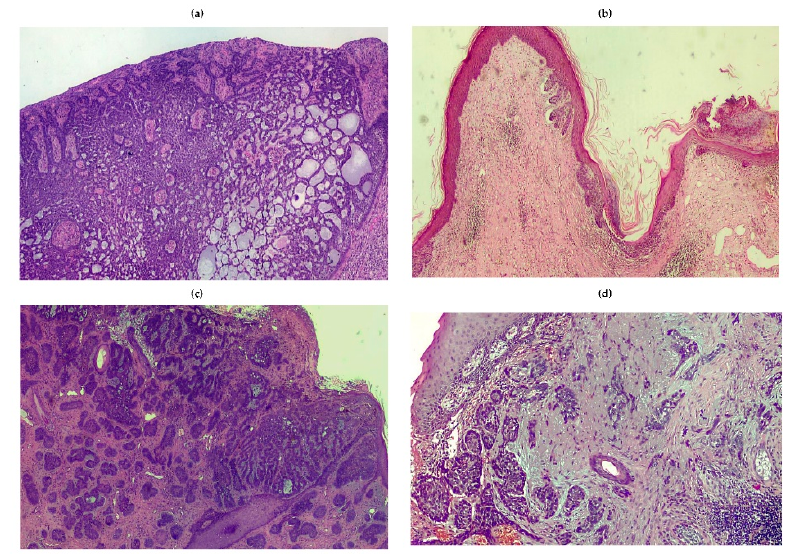
Figure 2. Histologic patterns of BCC: ( a ) adenoid variant of nodular BCC showing island of tumor cells characterized by a cribriform pattern; ( b ) superficial BCC; ( c ) micronodular BCC; and ( d ) morpheaform variant showing malignant cells surrounded by a sclerotic stroma enriched in collagen. The infiltrative features are also shown.